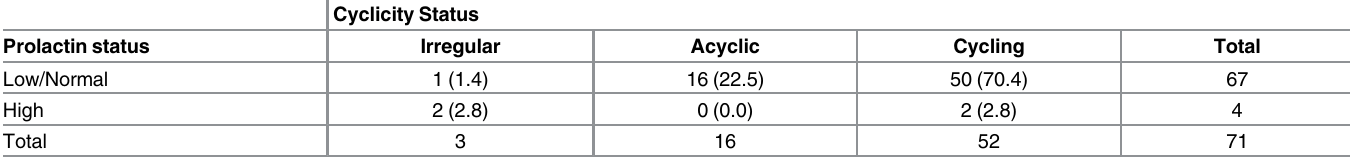
Table 5. Distribution/frequency (% of total) of Low/Normal ( < 14 ng/ml) and High ( (cid:1) 14 ng/ml) prolactin concentrations by cyclicity status for Asian